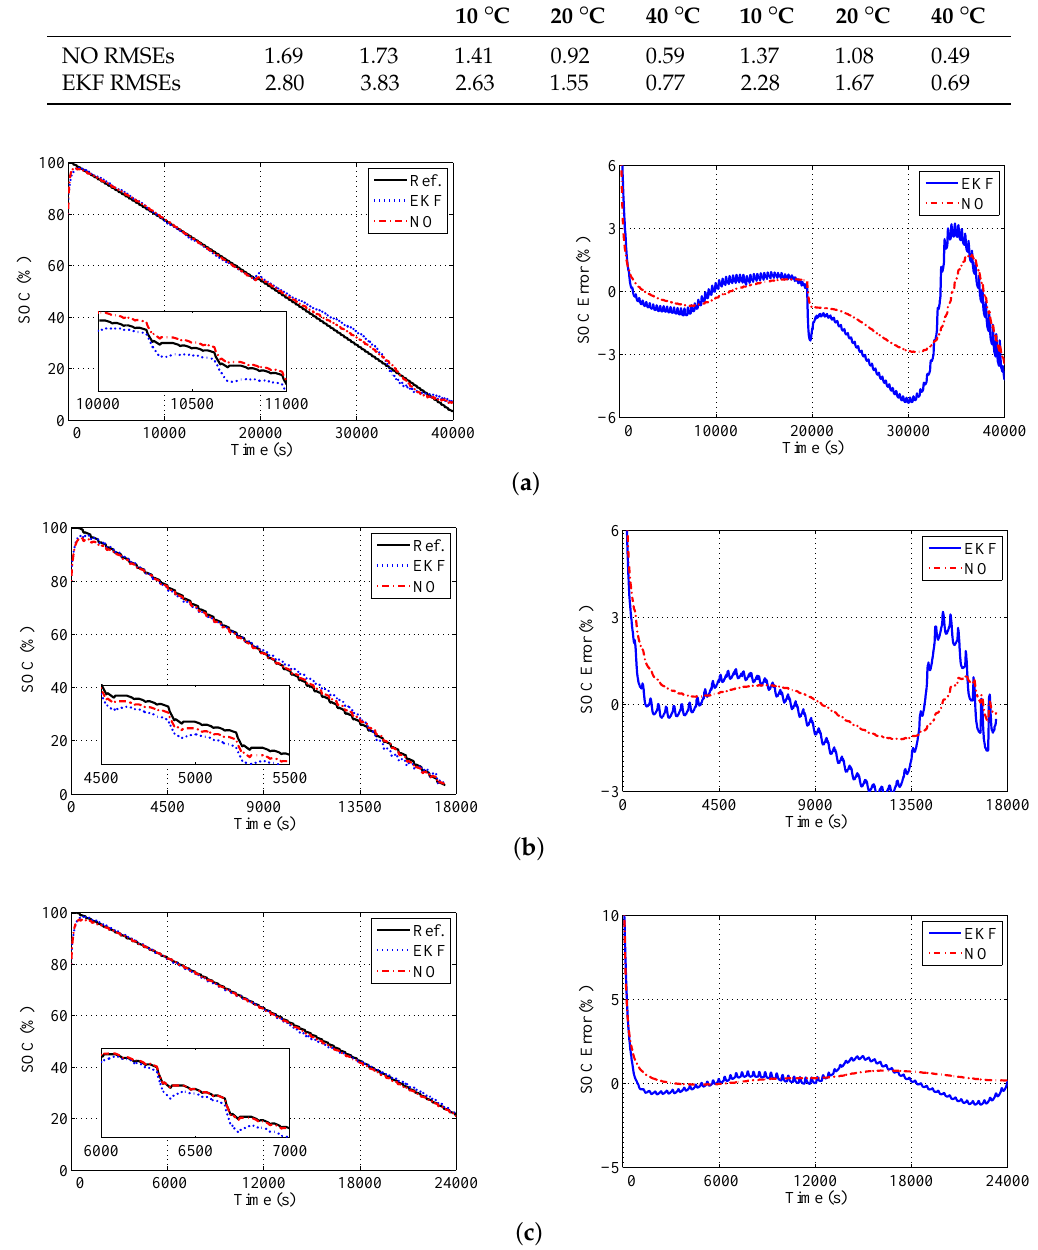
Figure 6. Estimation results of DST datasets from type 2 cell at different temperatures: ( a ) estimation results at 10 ◦ C ; ( b ) estimation results at 20 ◦ C ; and ( c ) estimation results at 40 ◦ C